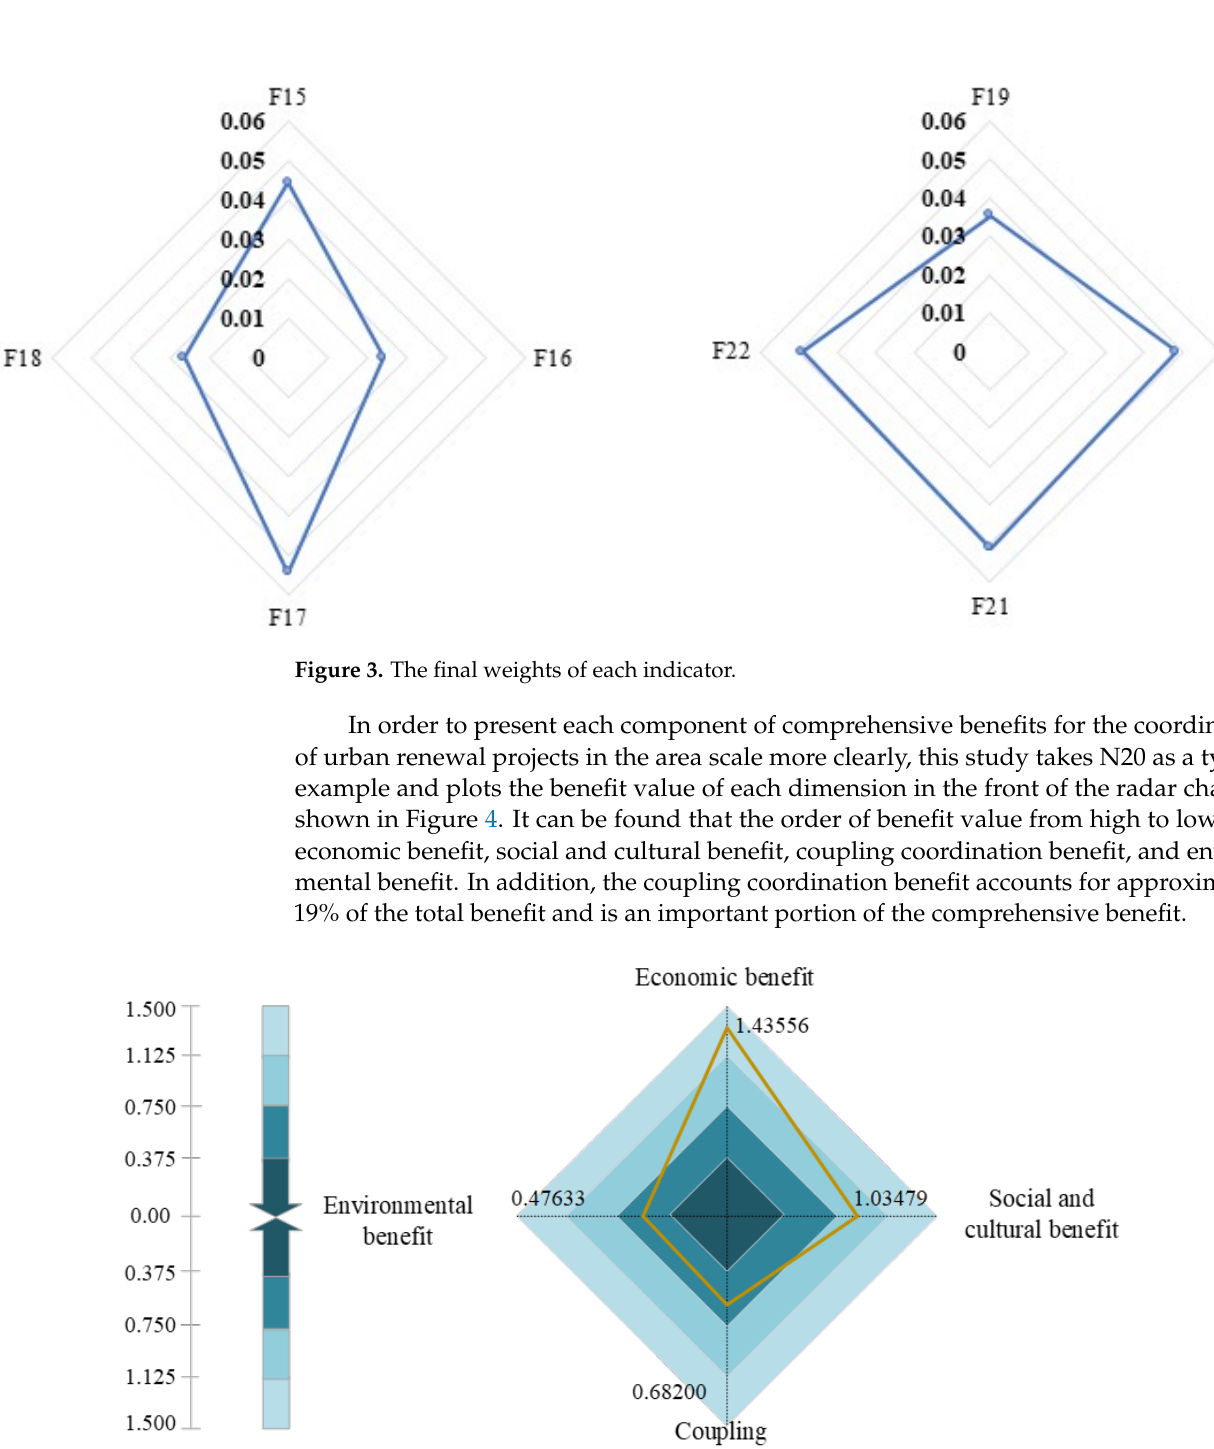
Figure 4. The comprehensive benefits of SPBSB area-scale renewal projects.